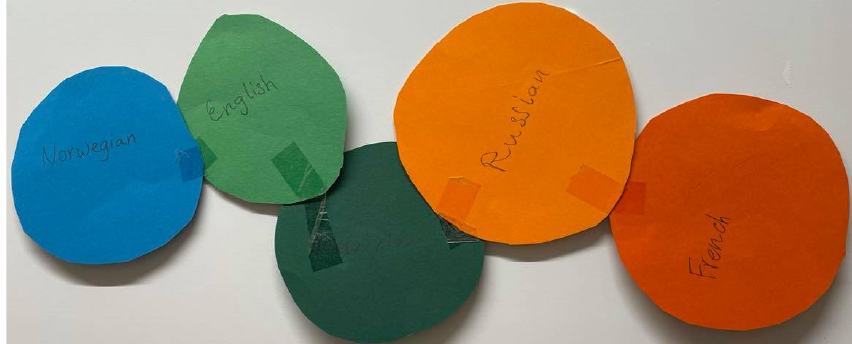
Figure 9. ST10’s DLC artefacts.